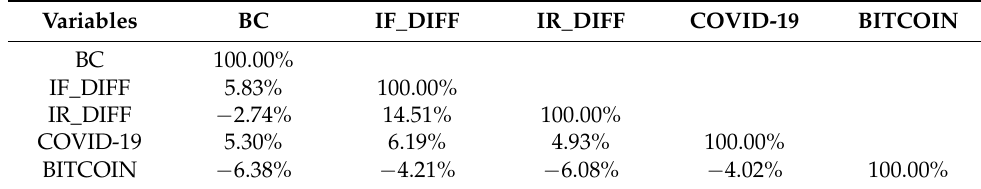
Table 2. Correlation matrix.